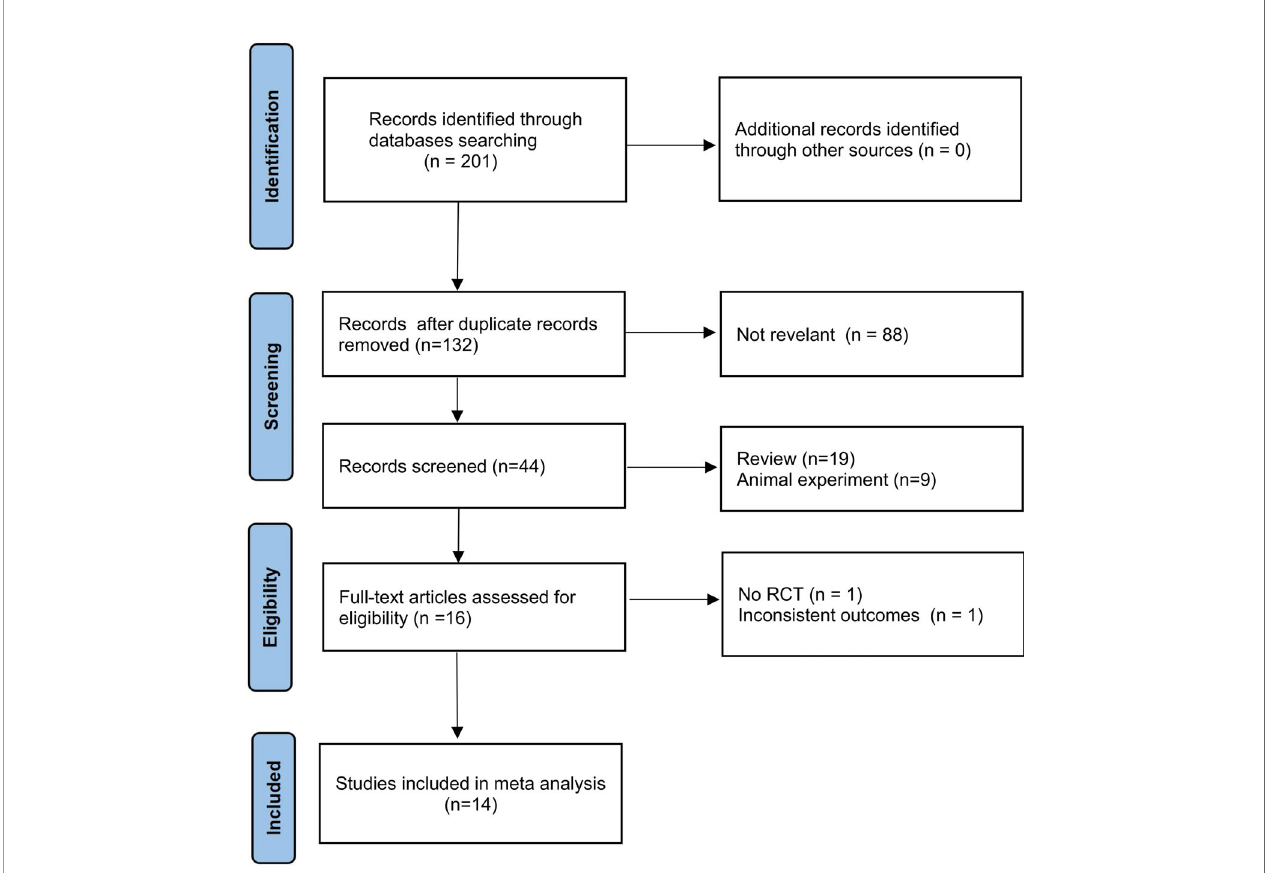
FIGURE 1 | Flow chart of studies